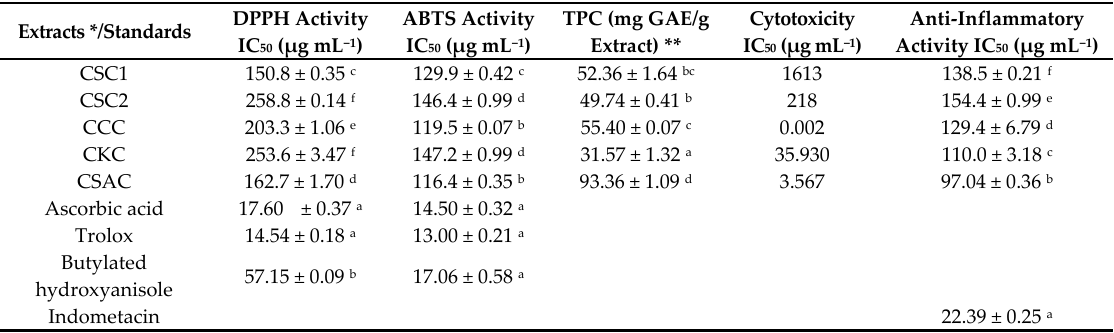
Table 2. Antioxidant and anti-inflammatory activities and total phenolic contents of chloroform extracts obtained from Centaurea